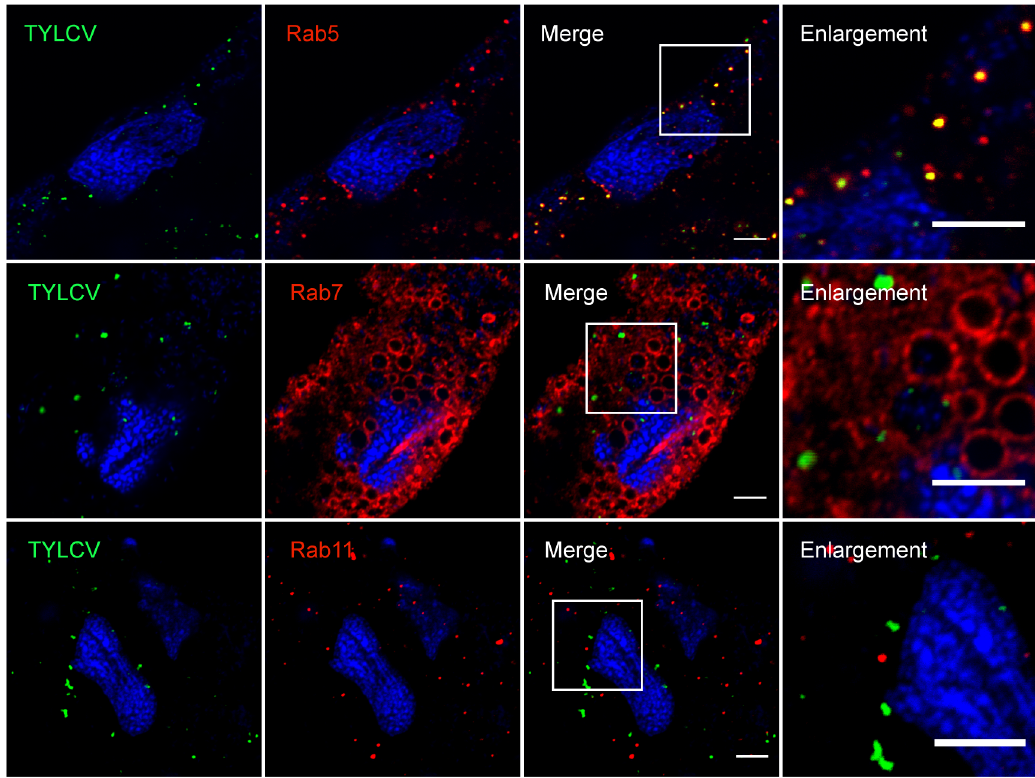
Fig 6. Colocalization of TYLCV and endosomes. Midguts of whiteflies exposed to TYLCV-infected tomato plants for a 3 d AAP were dissected and prepared for immunofluorescence. Antibodies against Rab5, Rab7 and Rab11 were used to label early endosomes, late endosomes and recycling endosomes, respectively. Colocalization between TYLCV and these structures were quantified as 0.36 ± 0.05, 0.05 ± 0.01, 0.04 ± 0.01, respectively (Pearson’s coefficient, mean ± SE, n = 11–15). Scale bar, 5 μ m. Representative images that were used to generate the data are provided in S9